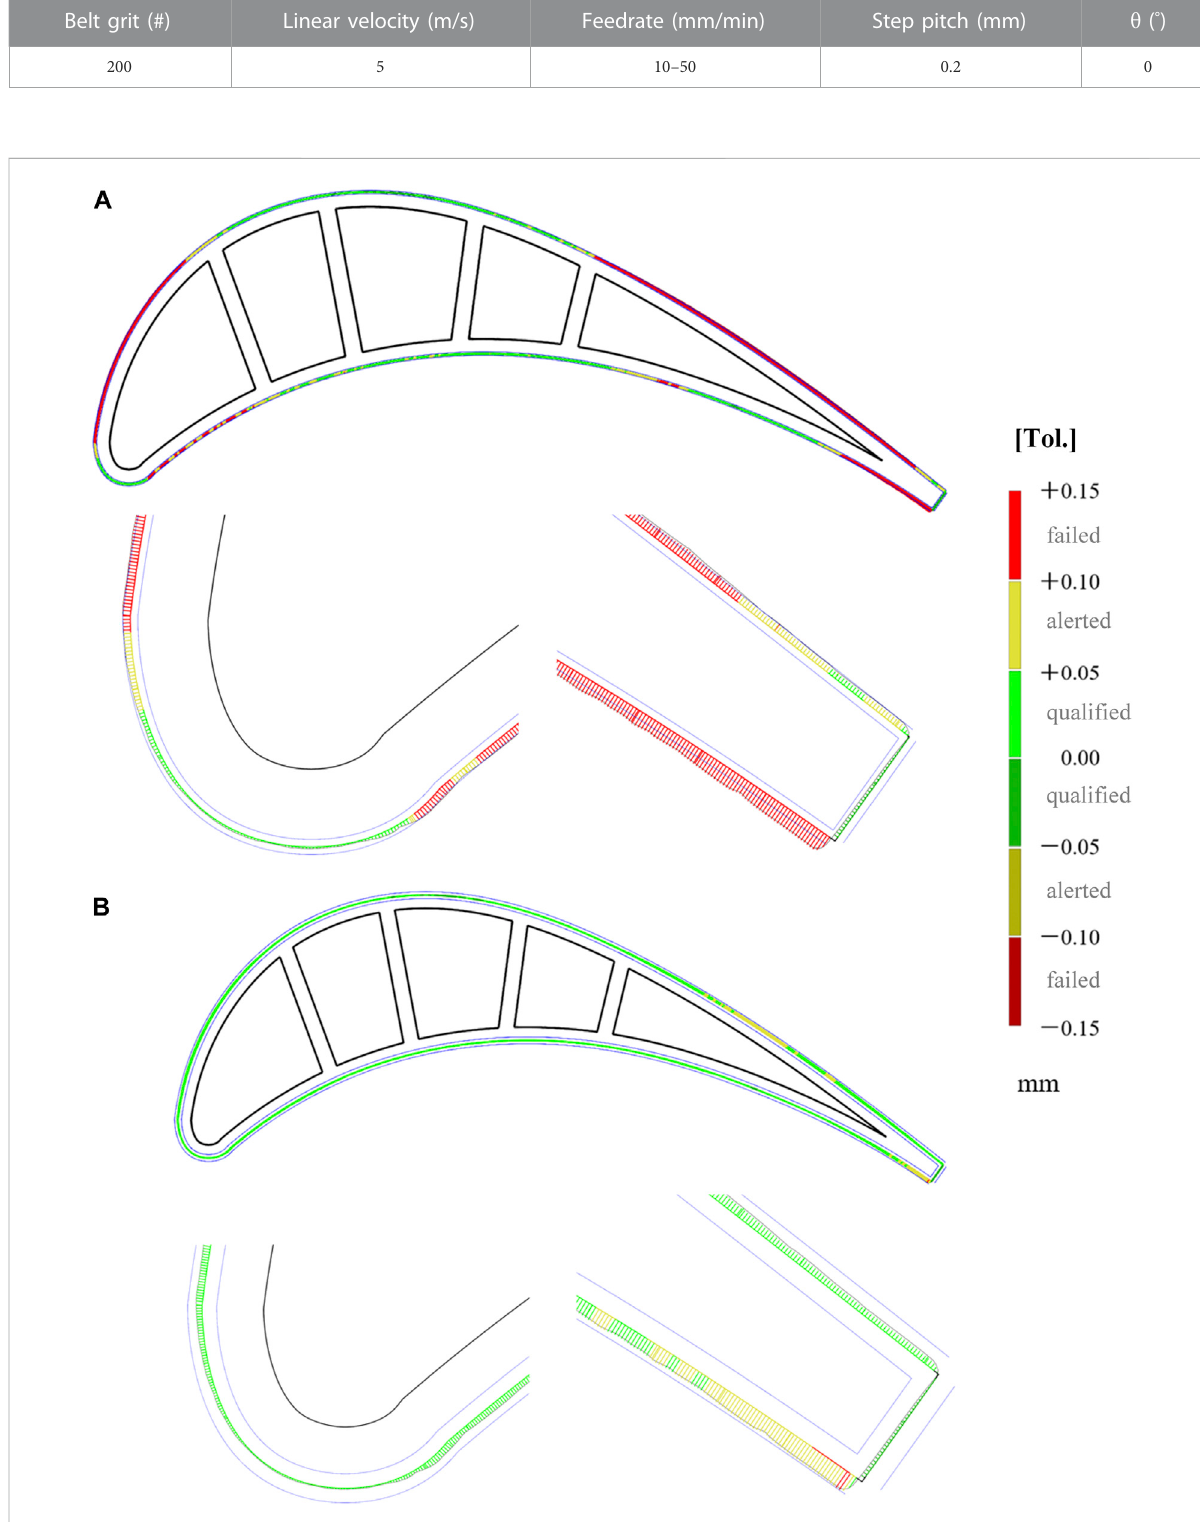
FIGURE 11 Hollow blade pro fi le deviation (A) before grinding (B) after